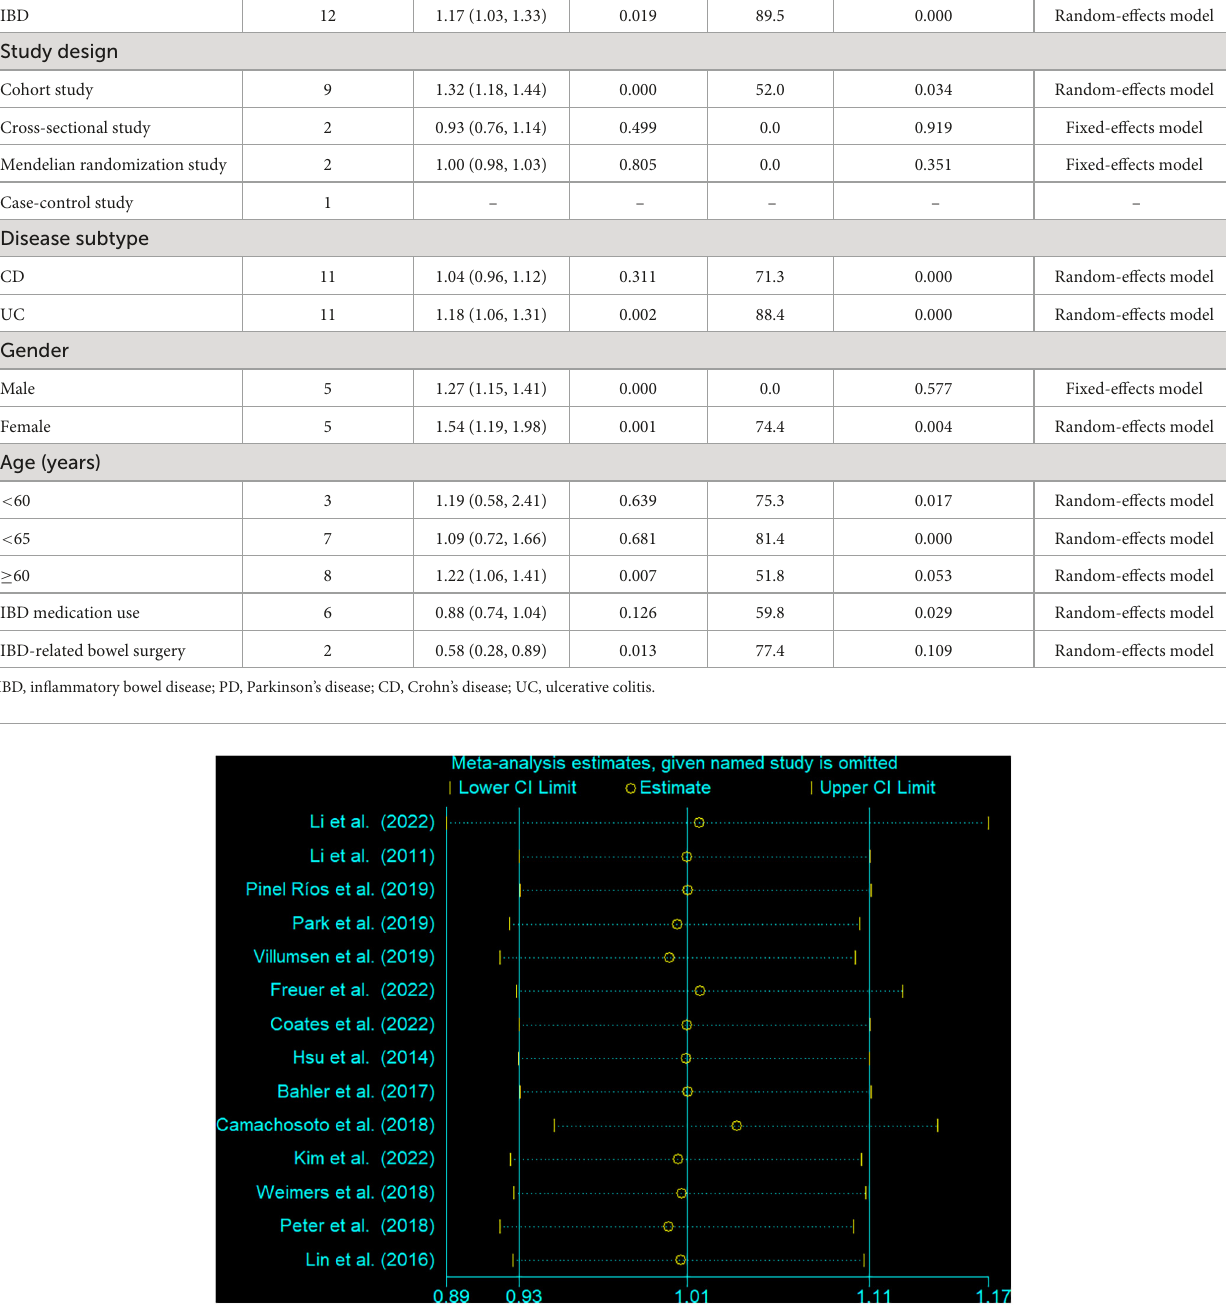
model to estimate cumulative effects, those results are not